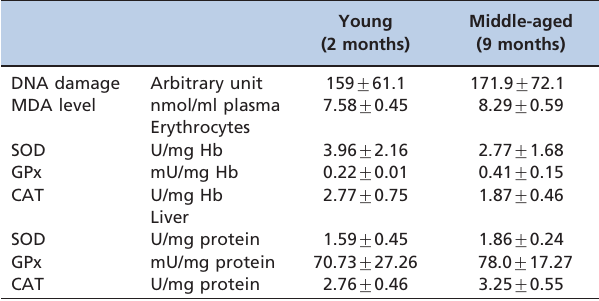
Table 2 - Baseline values of DNA damage and antioxidant enzyme activities of the young (2 months) and middle- aged (9 months)